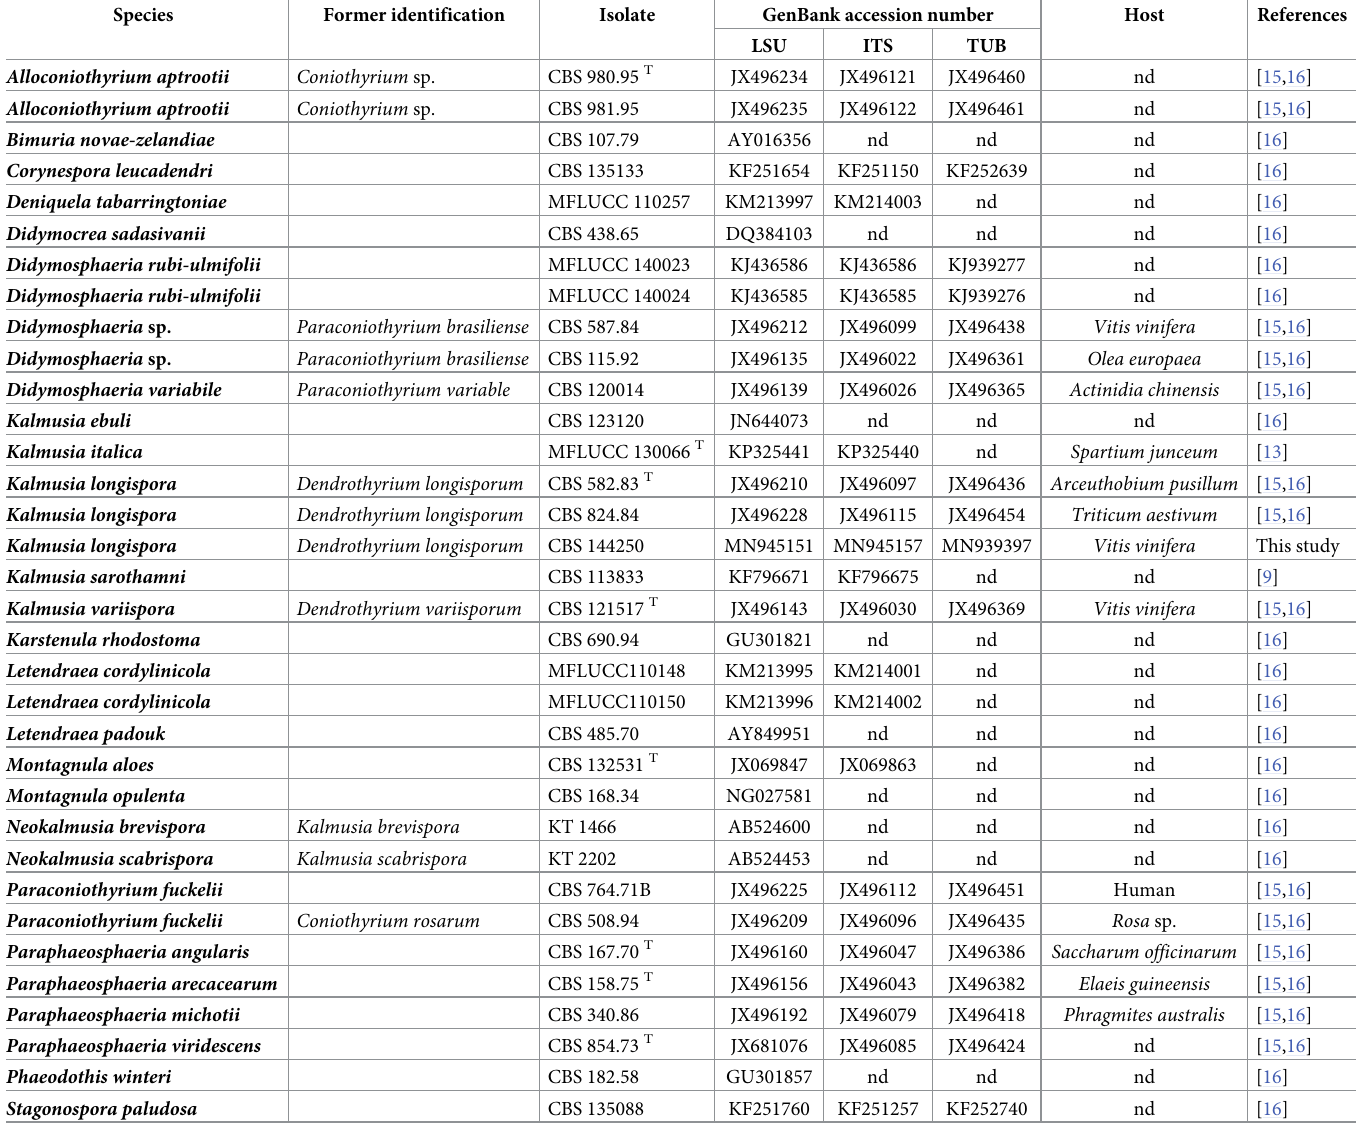
Table 1. List of the isolates included in the phylogenetic